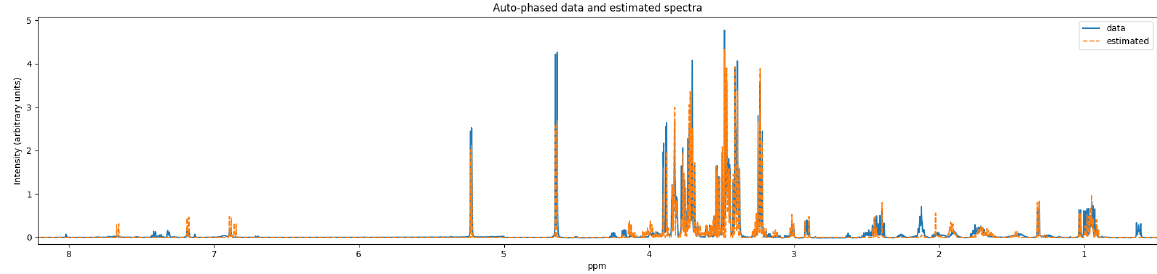
Figure 6. Reconstructed spectrum (orange, label: estimated) vs. the preprocessed data spectrum (blue, label: data).